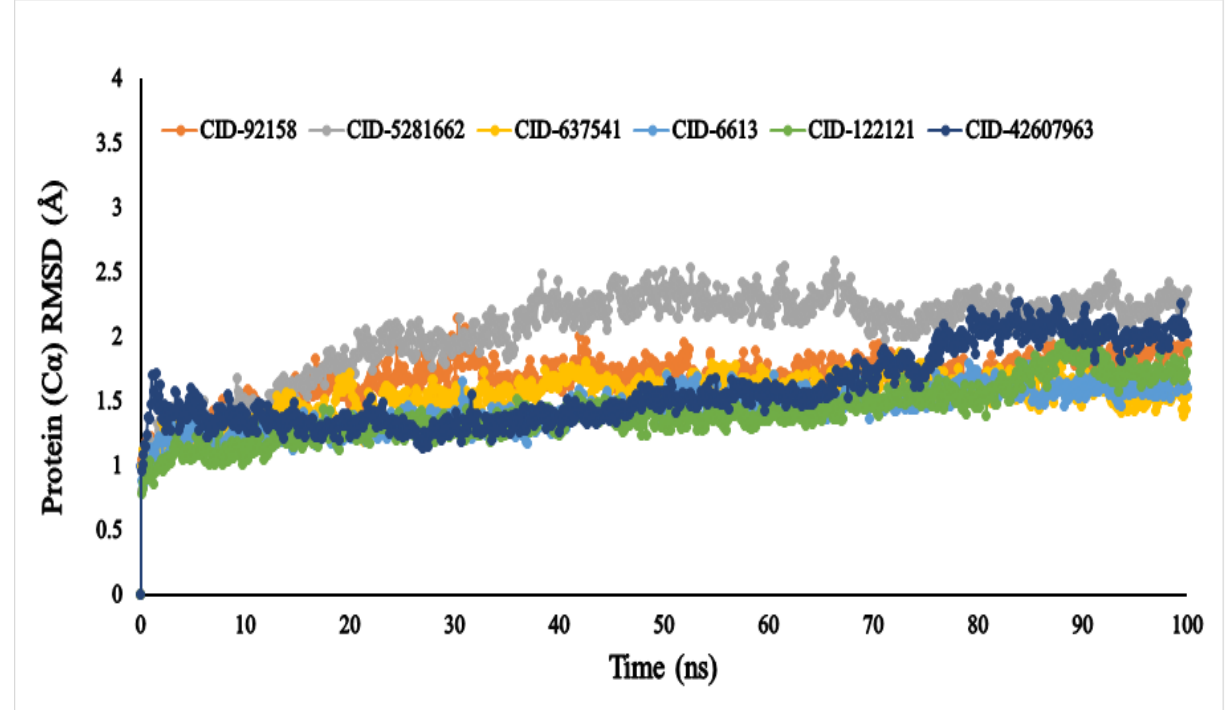
Figure 5. The RMSD values of the selected six compounds, viz., lupenone (CID: 92158), swertianolin (CID: 5281662), m -coumaric acid (CID: 637541), pantothenic acid (CID: 6613), phytosphingosine (CID: 122121), and 8- C -glucopyranosyleriodictylol (CID: 42607963), in association with the targeted protein α -glucosidase (PDB ID: 3A4A) are depicted by specific colour.